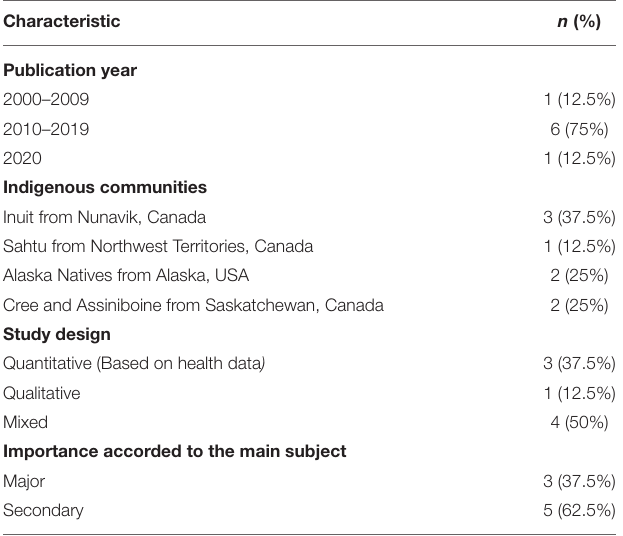
TABLE 1 | General characteristics of included scoping reviews ( n = 8) (total percentages may exceed 100% as publications have been classified in more than one